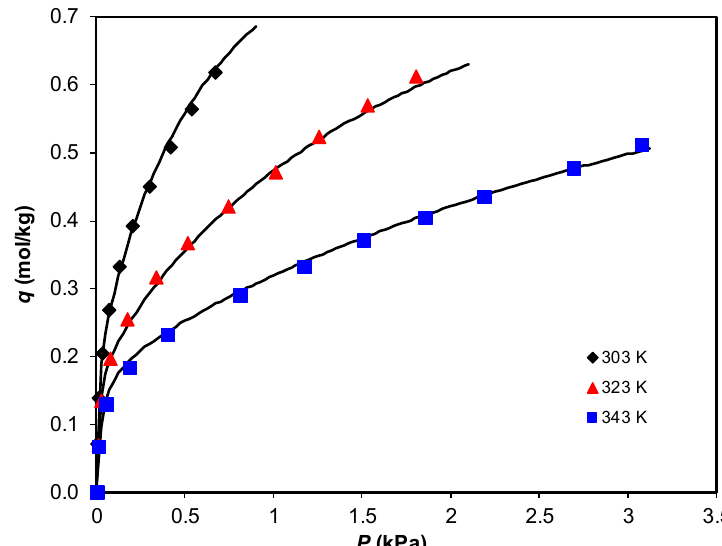
Figure 10. CO 2 /CH 4 ideal selectivity as a function of the partial pressure in an equimolar mixture at 303 K ( ♦ ), 323 K ( ▲ ), and 343 K ( ■ ).